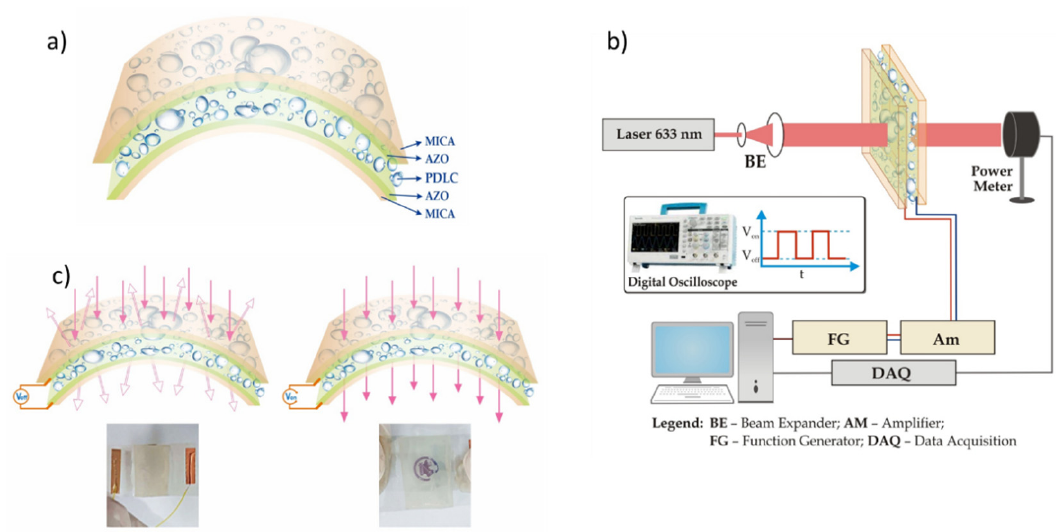
Figure 6. ( a ) Schematic structure of AZO on mica PDLC device ( b ) an experimental set-up to measure voltage-transmittance characteristics and the response time ( c ) principle of work demonstrating image of NCTU of AZO on mica PDLC device at “off” and “on” states. (Supplementary Materials, video demonstration (“off” and “on” states and flexibility).